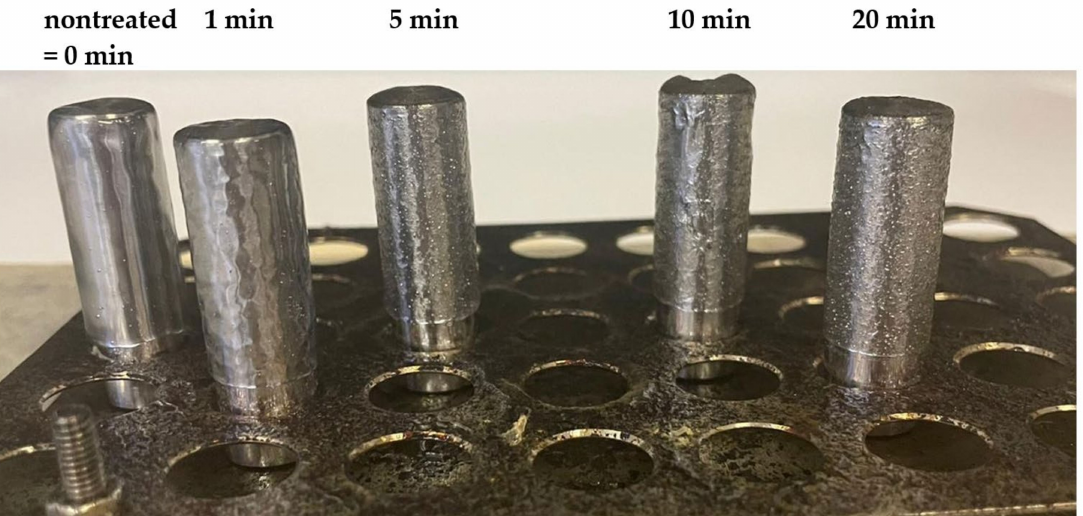
Figure 5. The process of melting polymer powder treated by air (timeline) into metal rod and surface